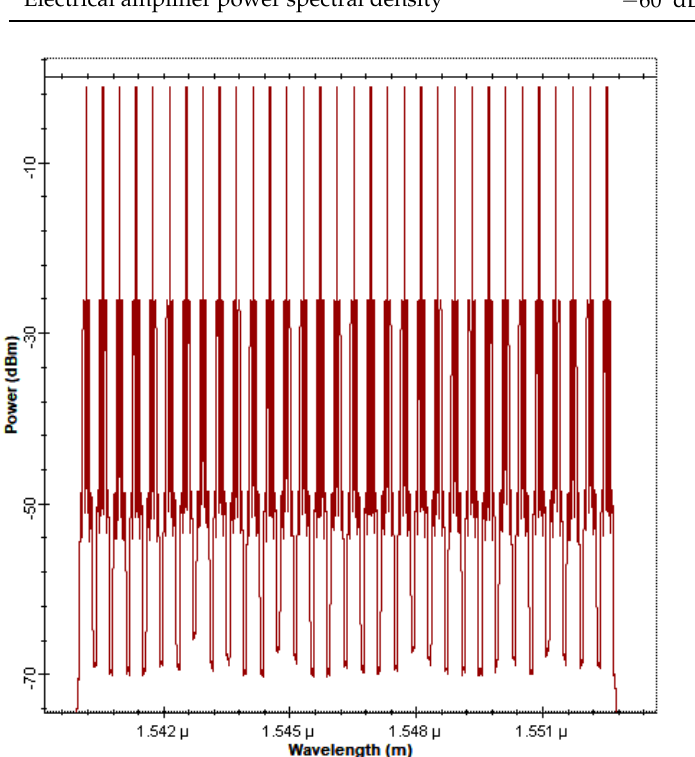
Figure 3. Spectrum of proposed 32-channel WDM-FSO